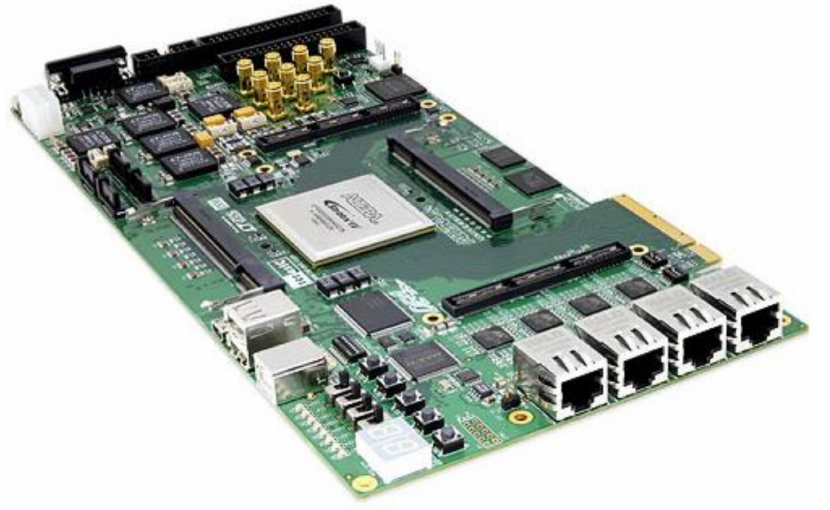
Figure 7. Altera DE4-320 FPGA Development Board.